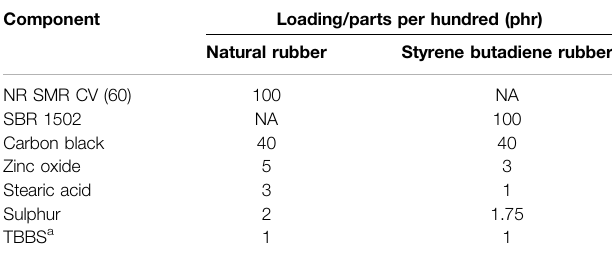
TABLE 1 | Composition of tested compounds. Component